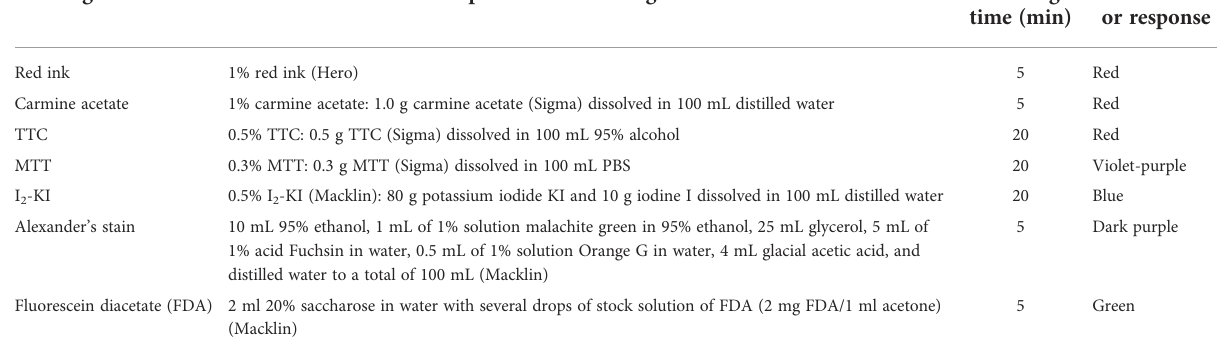
TABLE 2 Method to assess pollen viability. Staining